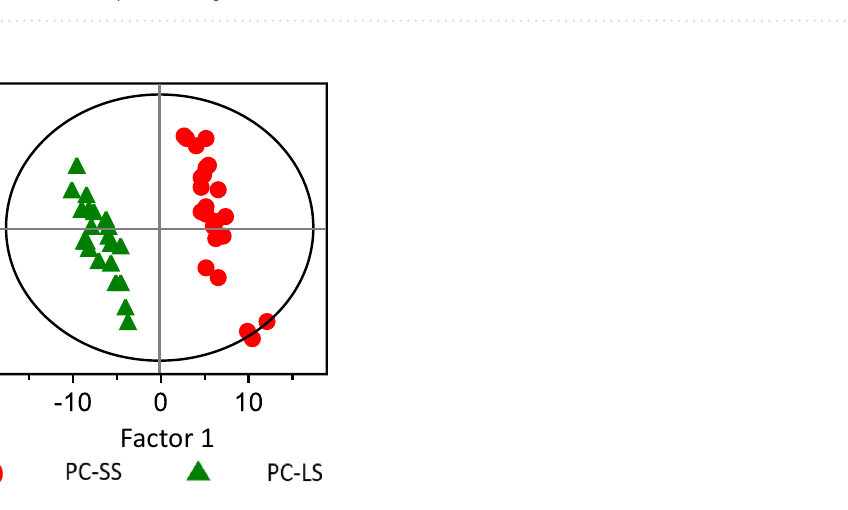
Table 2. Comparison of characteristics between long-term and short-term survivors after blood sample collection. PC Pancreatic cancer, LS long-term survivor, SS short-term survivor, CEA carcinoembryonic antigen, CA19-9 carbohydrate antigen 19-9.